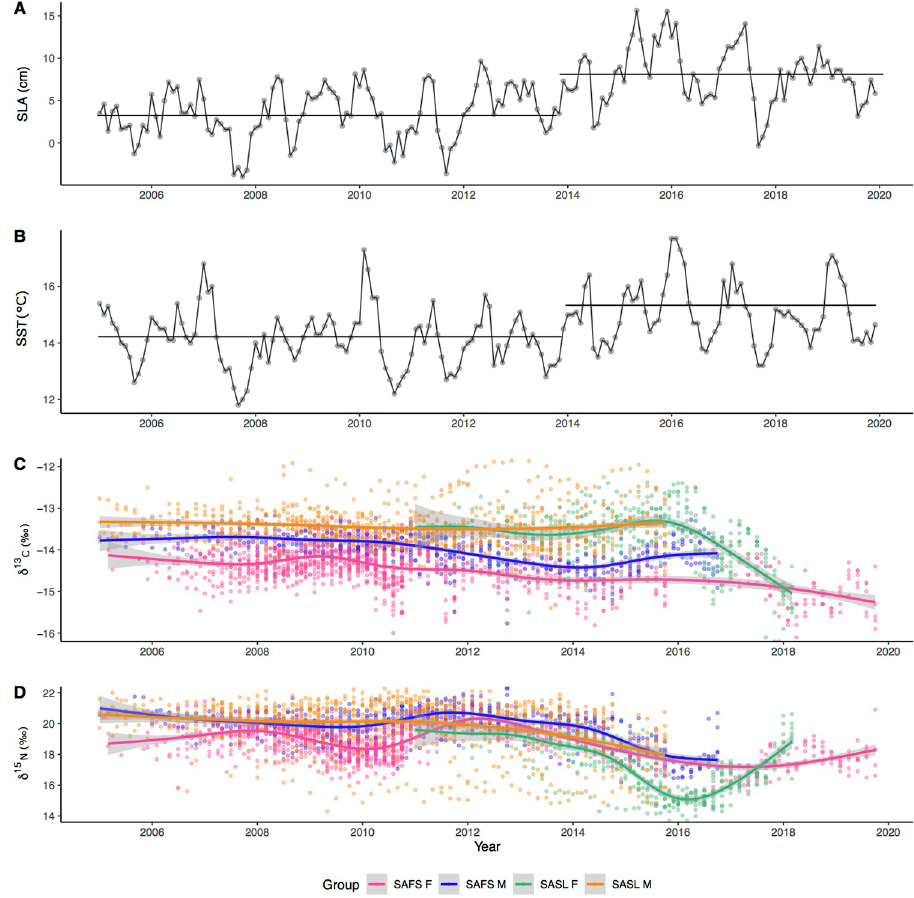
Fig 1. Time series for A) monthly sea level anomaly (SLA, cm) and D) sea surface temperature (SST,˚C) from study area. Horizontal lines show start / end of Period 1 (mean = +3.4 cm) and Period 2 (mean = +8.1 cm) in SLA and start / end of Period 1 (mean = +14.1˚C) and Period 2 (mean = +15.1˚C) in SST. C) δ 13 C and D) δ 15 N isotopic signatures for all otariid groups.